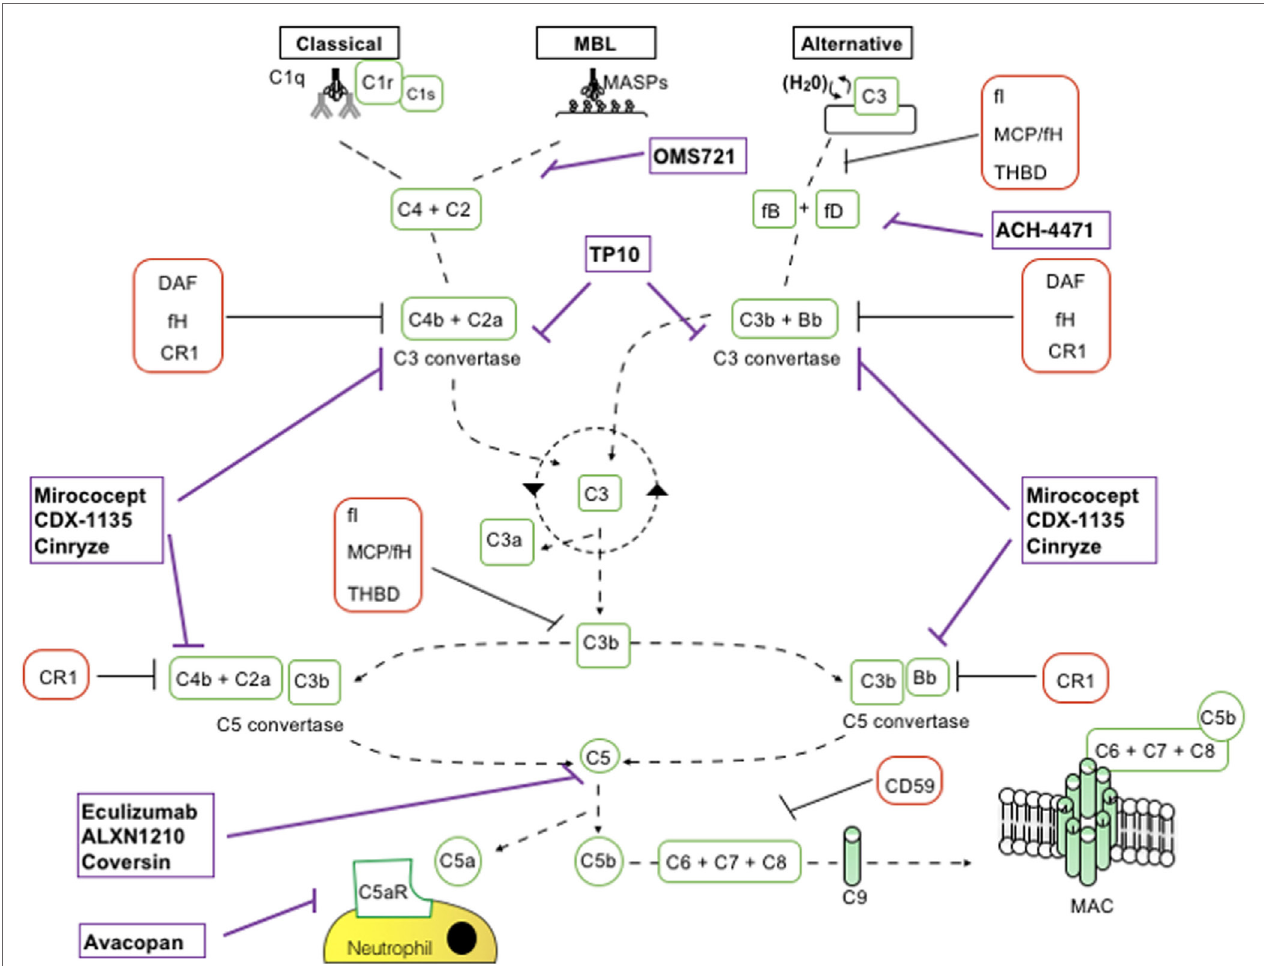
FigURe 1 | Schematic representation of complement activation pathways and complement-targeting agents. C1q,r,s cross-linking of antibodies activates the classical pathway. Mannose-associated serine proteases (MASPs) bind to mannose motifs expressed on bacteria to activate complement via the mannose-binding lectin (MBL) pathway. Subsequent cleavage and assembly of C2 and C4 proteins form the C3 convertase. The spontaneous hydrolysis of C3 on cell surfaces leads to the alternative pathway (AP): C3 convertase dependent on factor B (fB), factor D (fD), and properdin. The resultant C3 convertases can continuously cleave C3; however, after they are generated, the AP C3 convertase dominates in amplifying production of C3b (green looping arrow). C3 convertases cleave C3 into C3a and C3b. C3b permits the formation of C5 convertase. C3b has further roles in opsonization and immune complex clearance. C5b, in conjunction with C6–C9, allows formation of the membrane attack complex (MAC) and subsequent pathogen lysis. Decay accelerating factor (DAF) (CD55) and MCP (CD46) are cell surface- expressed complement regulators that accelerate the decay of all surface-assembled C3 convertases, thereby limiting amplification of the downstream cascade. MCP and factor H (fH) also have cofactor activity: in conjunction with soluble fI, they irreversibly cleave C3b to iC3b, thereby preventing reformation of the C3 convertase. CD59 inhibits formation of the MAC.